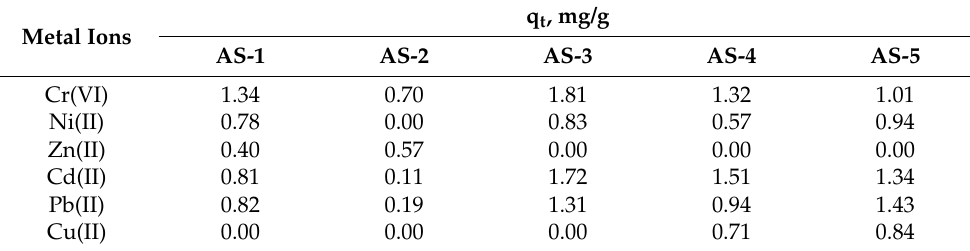
Table 1. Sorption capacities (q t , mg/g) of the investigated active substrates (ASs) depending on metal ion binding. The concentration of metal ions for S-1 and S-2 was 10 mg/L, and that for S-3 was 5 mg/L. For experiments with AS-1 , AS-2 , AS-3 and AS-5 , and AS-4 , the S-2 , S-1 , S-3 , and S-4 solutions were used, respectively. The details are described in paragraph 4.3 and paragraph